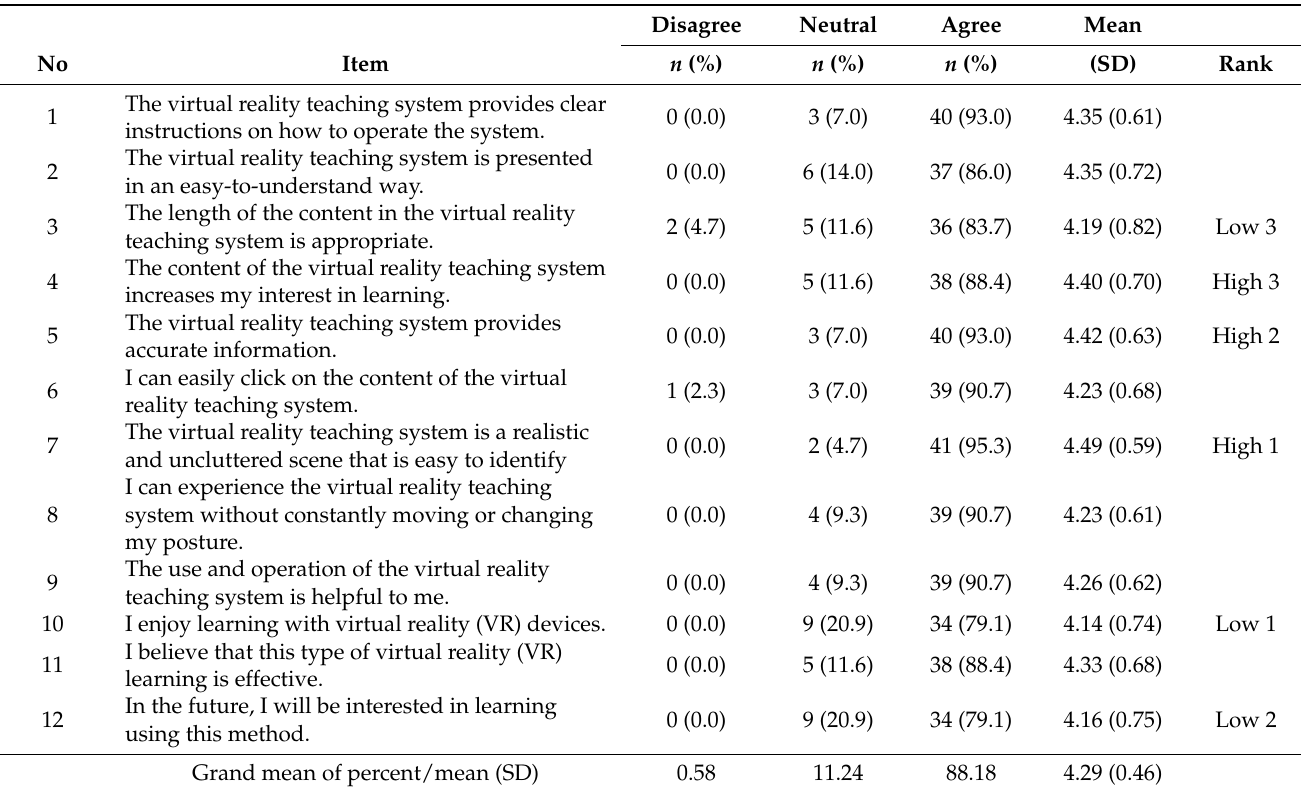
Table 7. Distribution of learning attitude using virtual reality for implanted Port-A catheter care ( n =